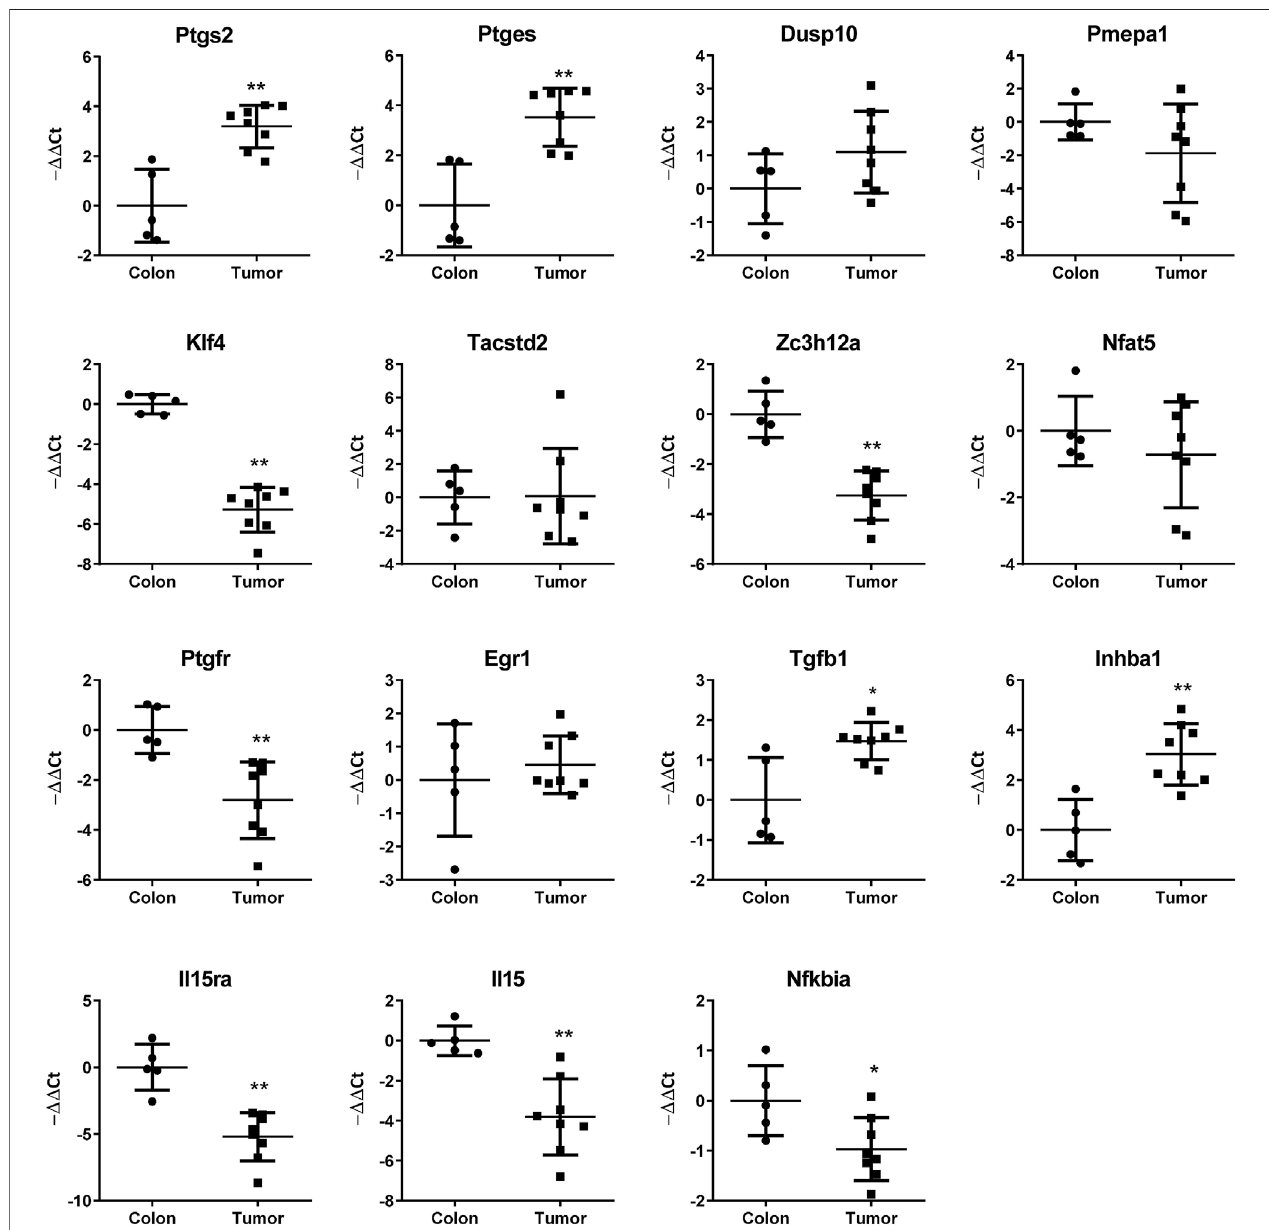
FIGURE 2 | mRNA levels of the indicated genes in mouse colon and CT29 cell-derived orthotopic allografts as estimated by RT-qPCR. − ΔΔ CT values are shown ( Δ CTnormal colon- Δ CTsample). Mann – Whitney U test was performed for statistical signi fi cance of the differences in gene expression. *: p < 0.05; **: p < 0.001.